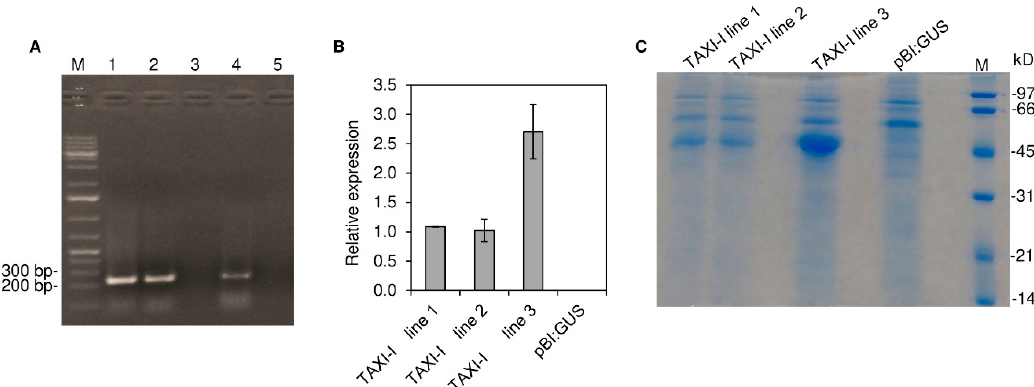
Figure 2. Selection and characterization of transgenic Arabidopsis thaliana transgenic plants transformed with the pBI:TAXI-I or pBI:GUS constructs. ( A ) PCR amplification performed using gene-specific primers and the total genomic DNA of T 0 plants. Amplicons were separated on 1% ( w / v ) agarose gel. Samples: (1) TAXI-I line 1; (2) TAXI-I line 2; (3) pBI:GUS; (4) TAXI-I line 3; (5) water; M: marker. ( B ) The relative expression level of TAXI-I gene determined by quantitative RT-PCR (RT-qPCR) in four weeks old A. thaliana transgenic plants. Each transcript was normalized with the Arabidopsis ubiquitin gene set to 1. Data represent the average ± standard error (indicated by bars) of two RT-qPCR experiments. ( C ) SDS_PAGE analysis of extracellular fluids extracted by vacuum-infiltration from leaves of Arabidopsis transgenic lines transformed with the pBI:TAXI-I or pBI:GUS constructs. SDS-PAGE analysis was performed in 12% ( w / v ) polyacrylamide gel. M: